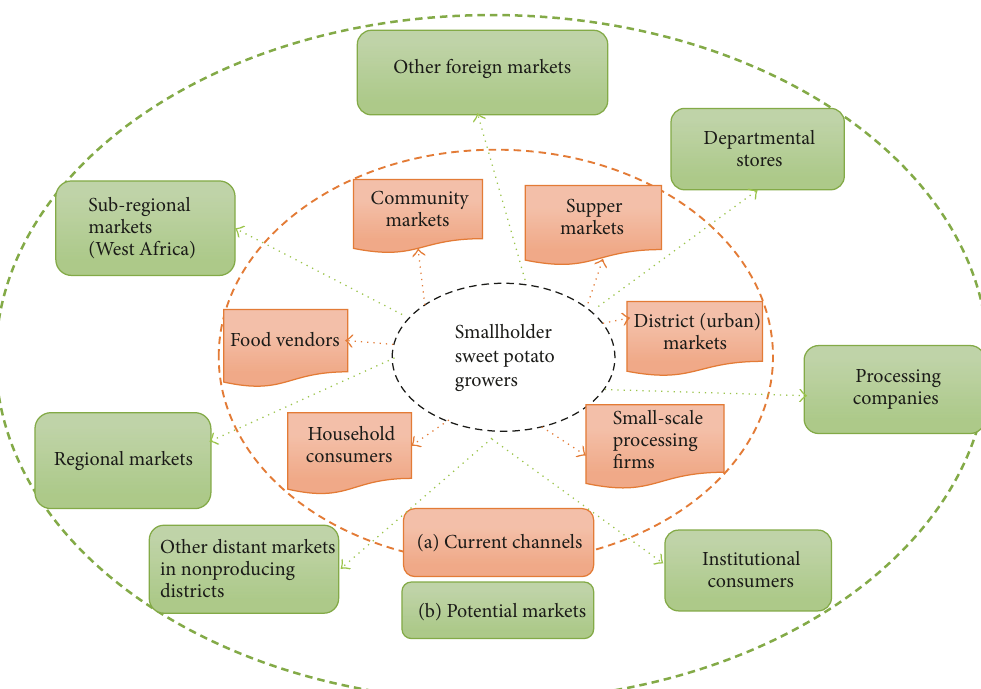
Figure 2: Market channels for fresh sweet potato root in